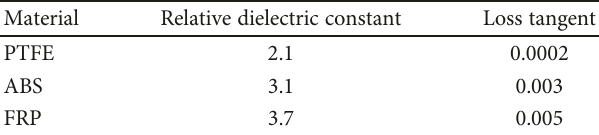
Table 1: Characteristics of di ff erent materials.